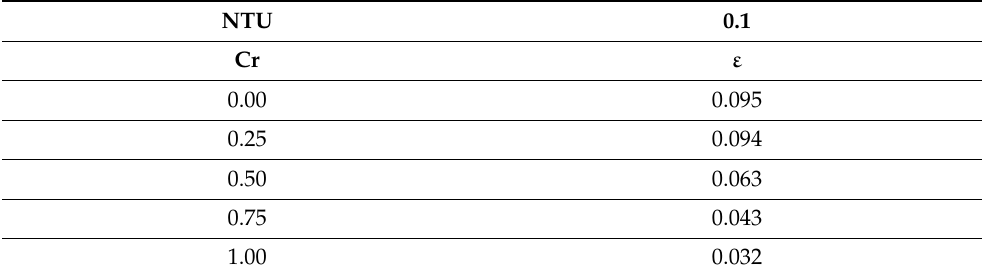
Table 5. Performance predictions of a 3-row pure cross flow heat exchanger in terms of dimensionless parameters. C min —External Fluid C max —Internal Fluid; sensible heat